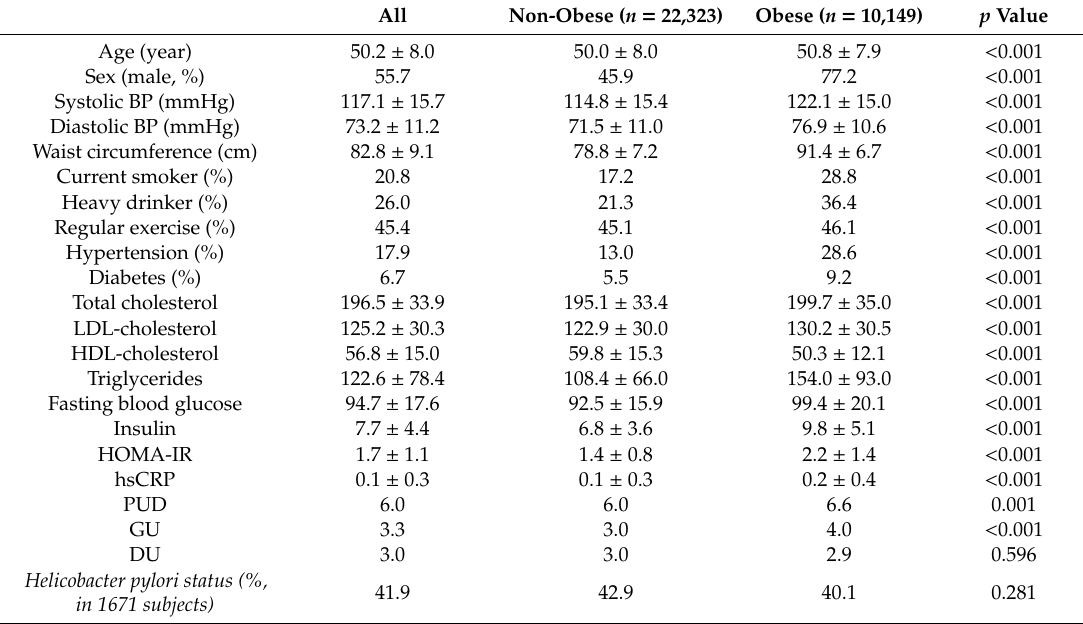
Table 1. Baseline characteristics of the study subjects according to